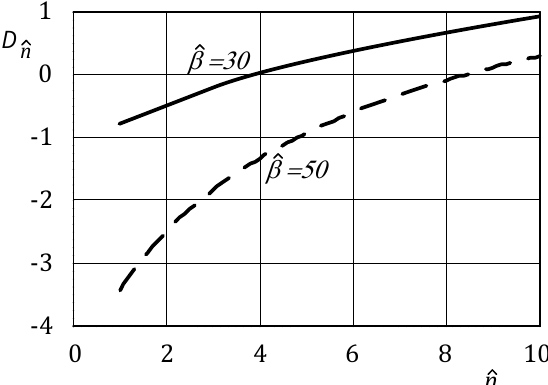
Figure 3. Graphs of D ˆ n depending on ˆ n for ˆ β = 30 and ˆ β = 50.